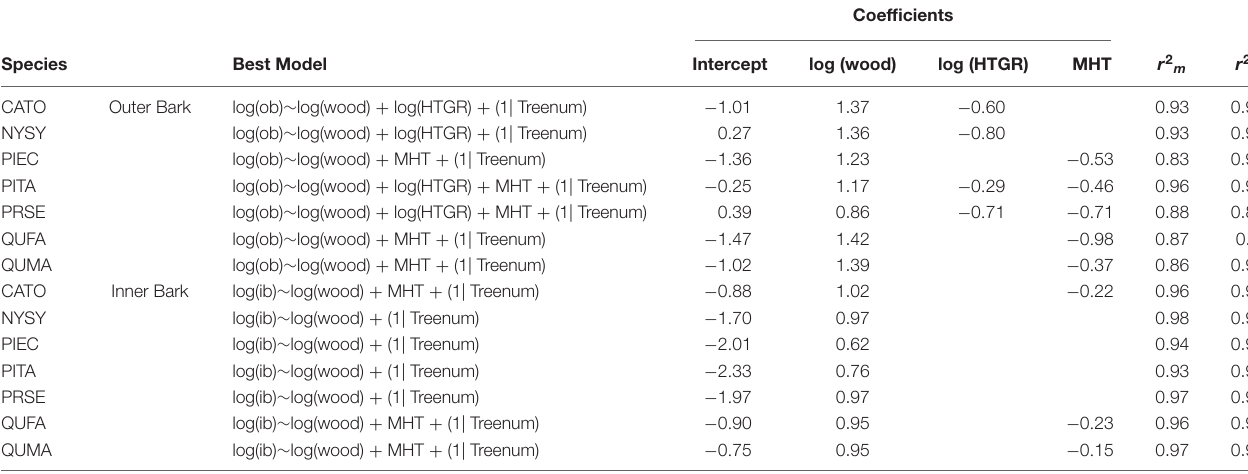
TABLE 4 | Outer (ob) and inner (ib) bark area models for saplings of seven native tree species.